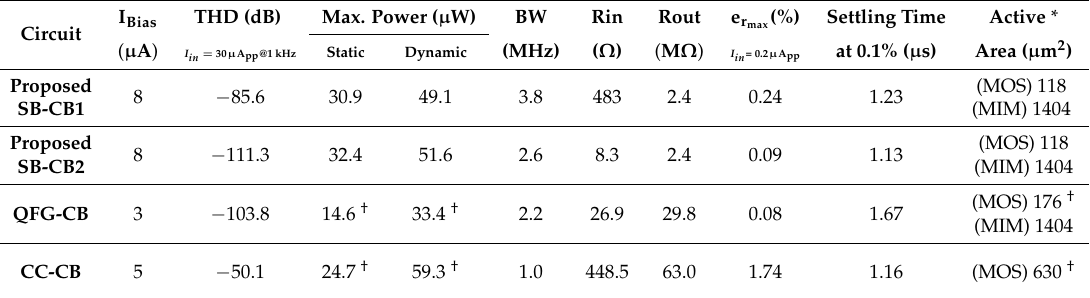
Figure 7. Response of the proposed circuit to an input current step: ( a ) SB-CB1; and ( b ) SB-CB2. Table 2. Class AB current buffer